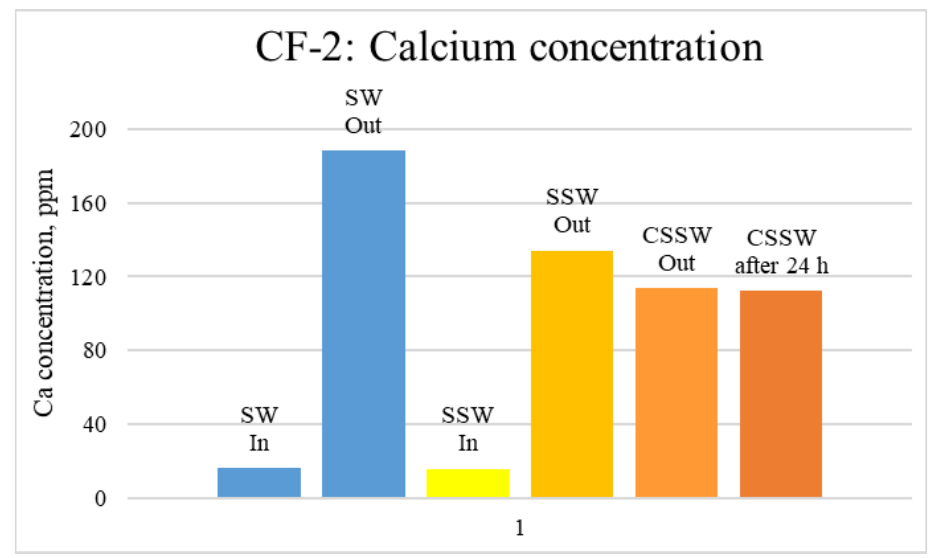
Figure 14. ICP analysis of CF1 brines: Sulfur concentration.